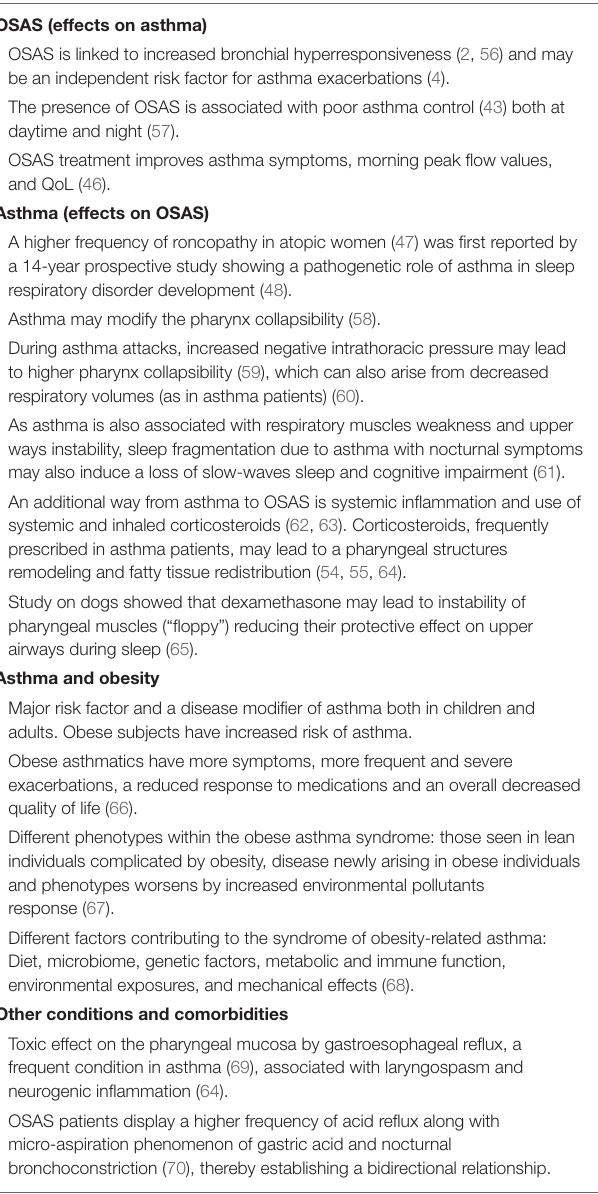
TABLE 3 | Mechanisms underlying the relationship between asthma and